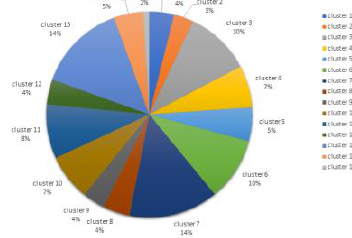
Figure 4. The size of each travel